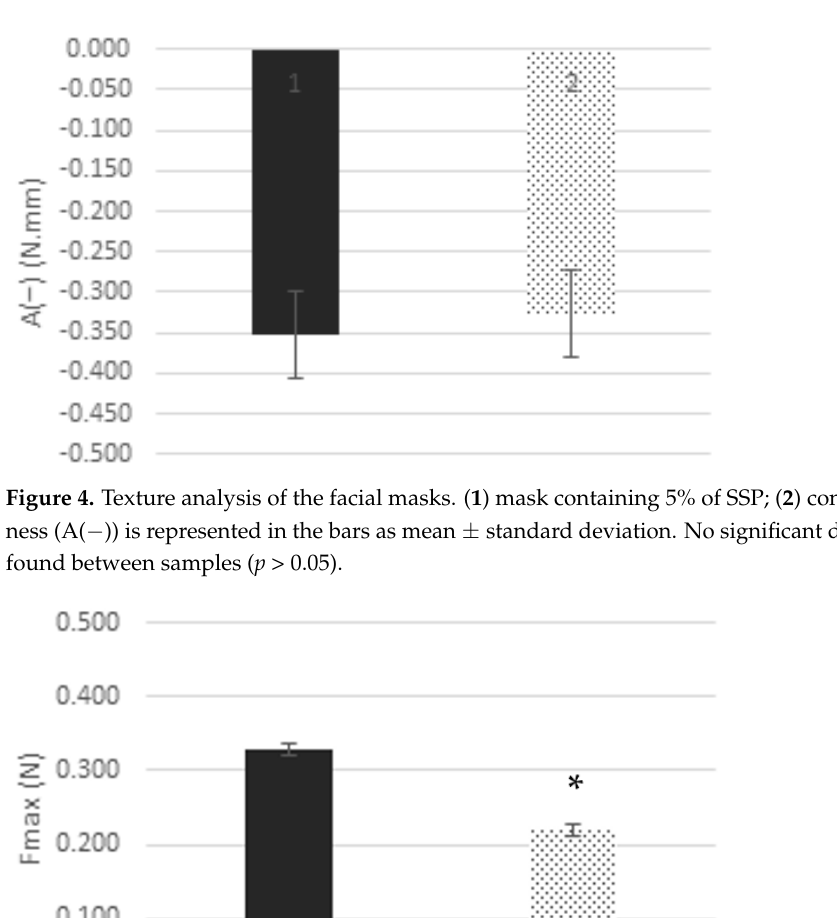
Figure 3. Rheograms, obtained for the control and 5% SSP-containing mask, at 20.00 ± 0.04 ° C.